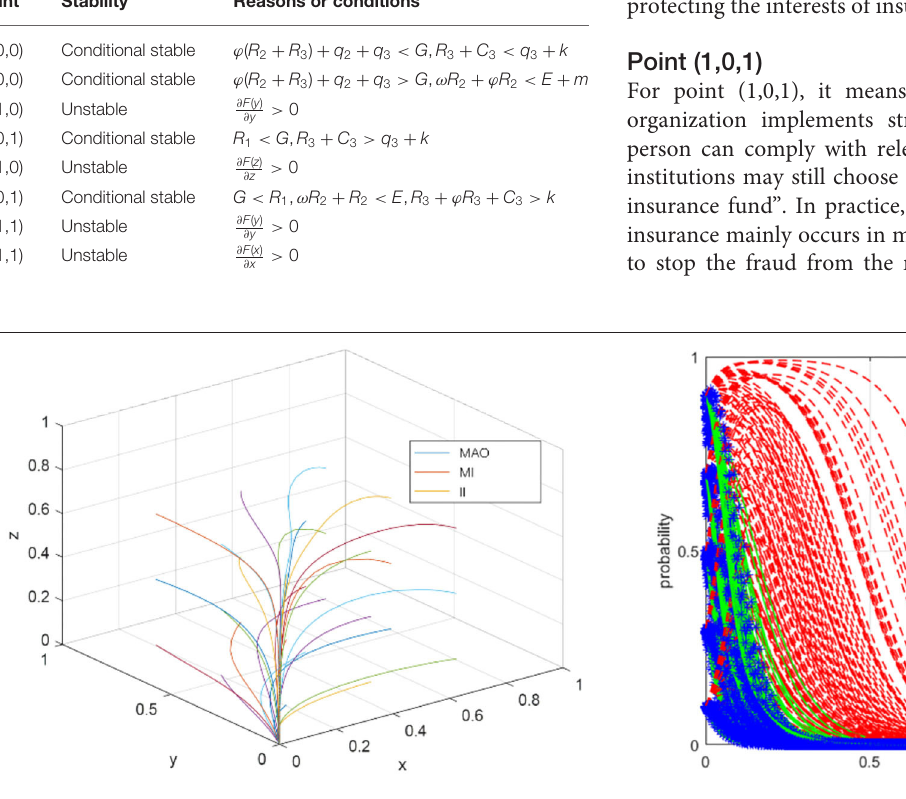
FIGURE 3 | The evolution toward the sink ESS